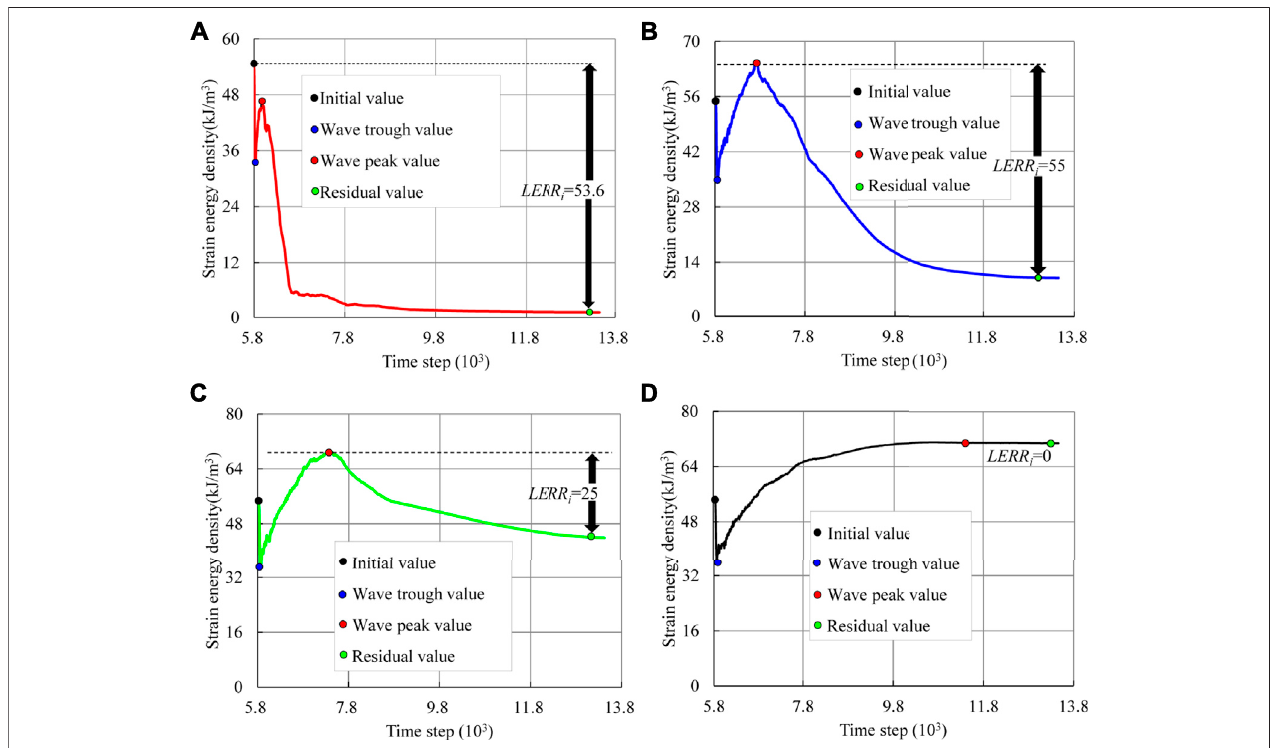
FIGURE 10 | Energy release process of surrounding rock masses induced by the transient unloading of in-situ stress: (A) Rock mass element with a distance of 0.5 m from the excavation boundary, (B) Rock mass element with a distance of 1.0 m from the excavation boundary, (C) Rock mass element with a distance of 1.5 m from the excavation boundary, (D) Rock mass element with a distance of 2.0 m from the excavation boundary.